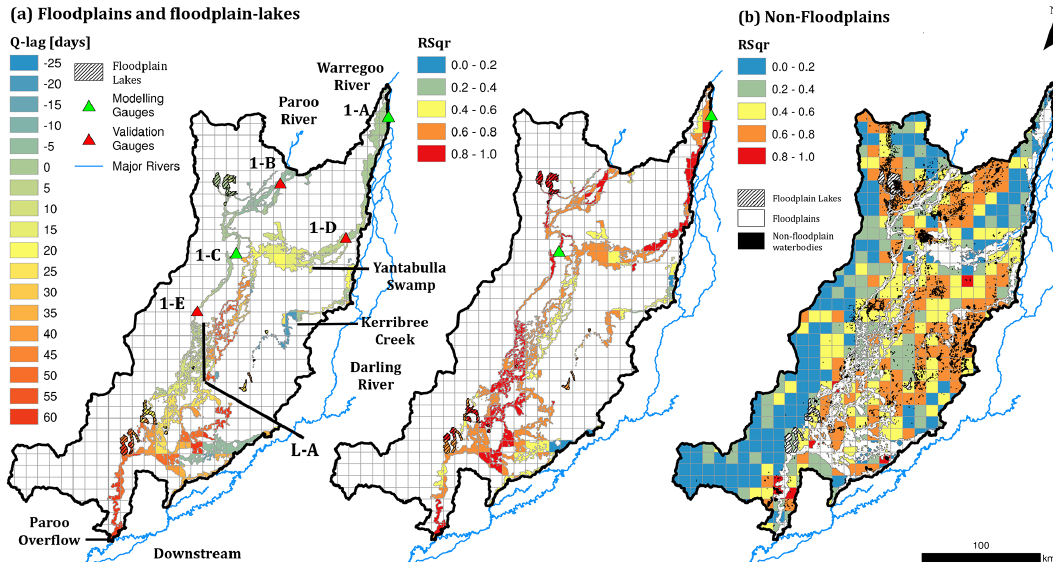
Figure 5. Model results of the Paroo sub-region: (a) Q lags and (b) r 2 for the floodplain, and floodplain-lake surface water category (final models) based on river gauge 1-A (all cells east of line L-A) and 1-C (all cells west of line L-A), (c) r 2 of non-floodplain category (final